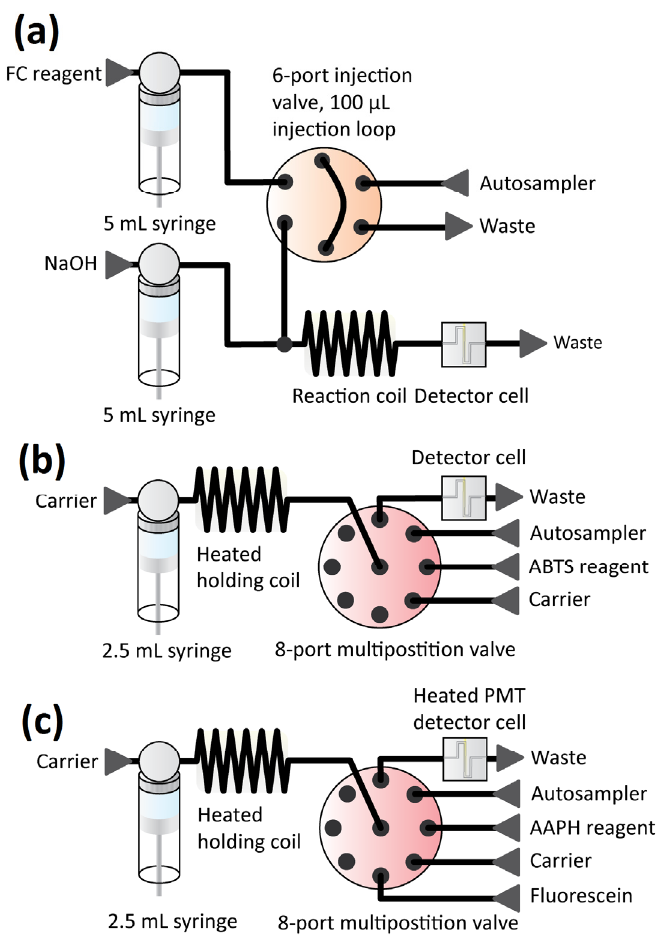
Figure 1. Schemes for antioxidant measurements by ( a ) FC, ( b ) ABTS and ( c ) ORAC